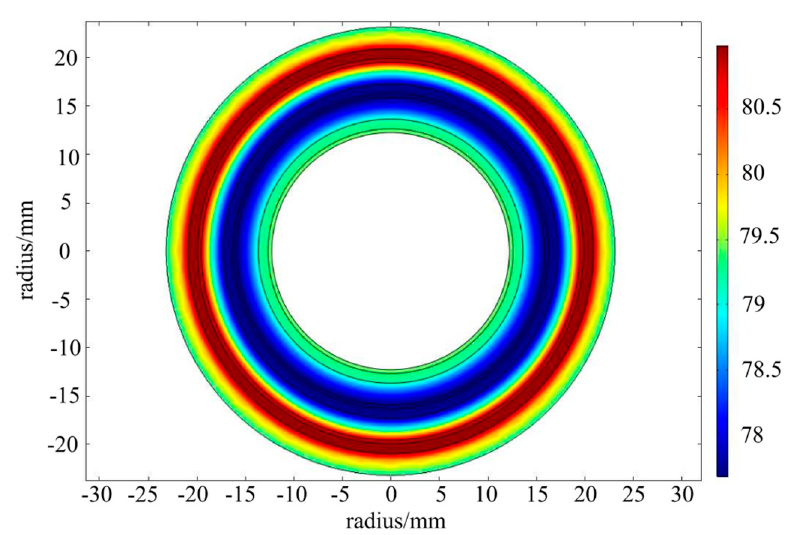
Figure 9. Temperature distribution of the cable conductor under fault current.